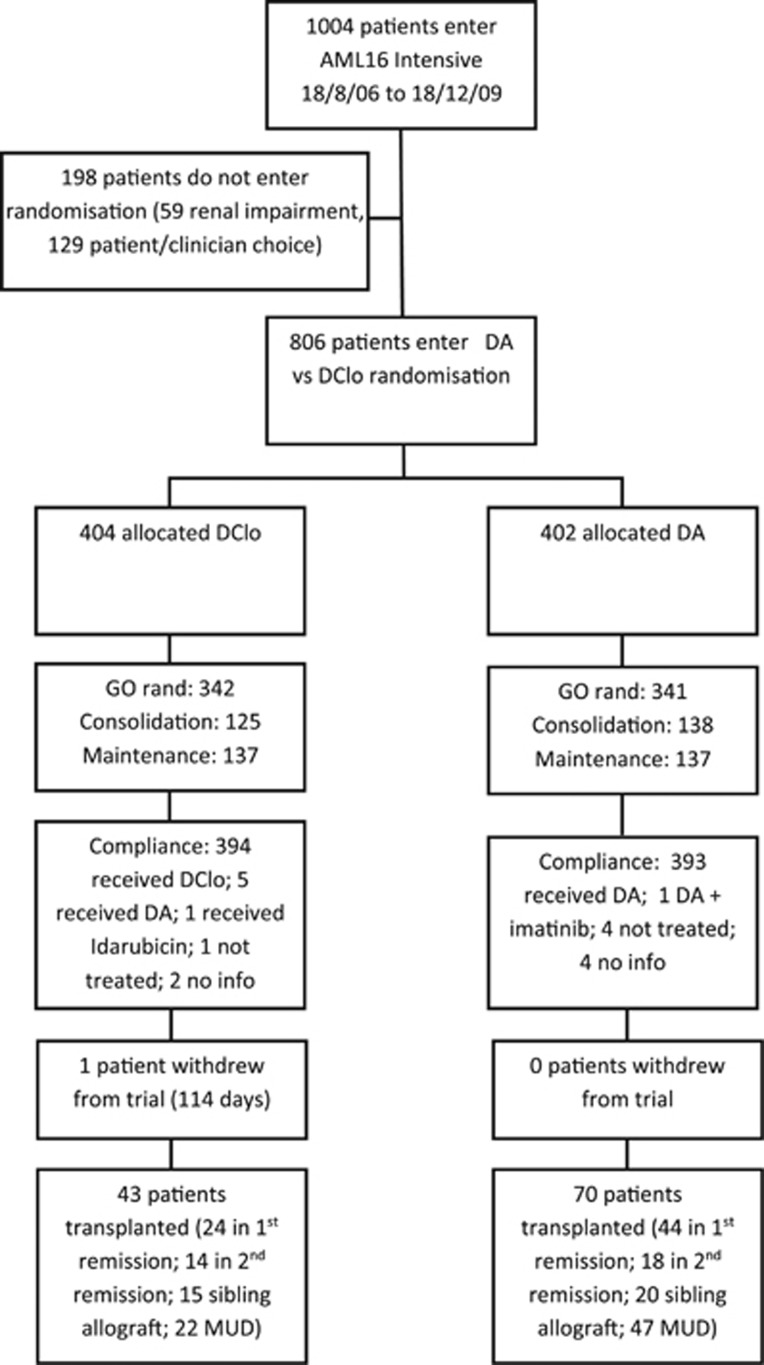
CONSORT diagram.